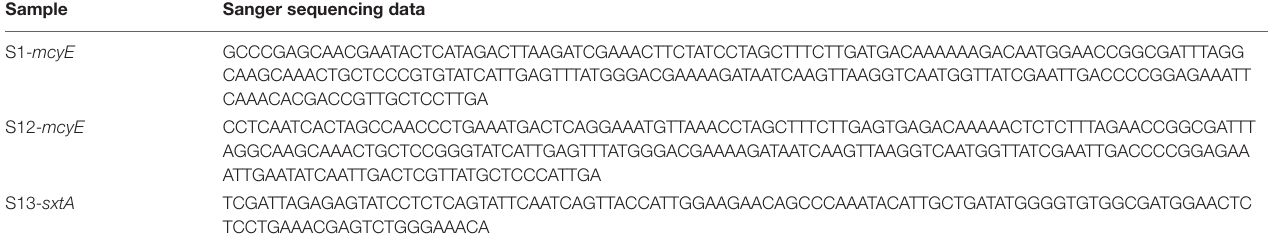
TABLE 2 | List of DNA sequences of PCR products from Ural River sampling sites. Sample